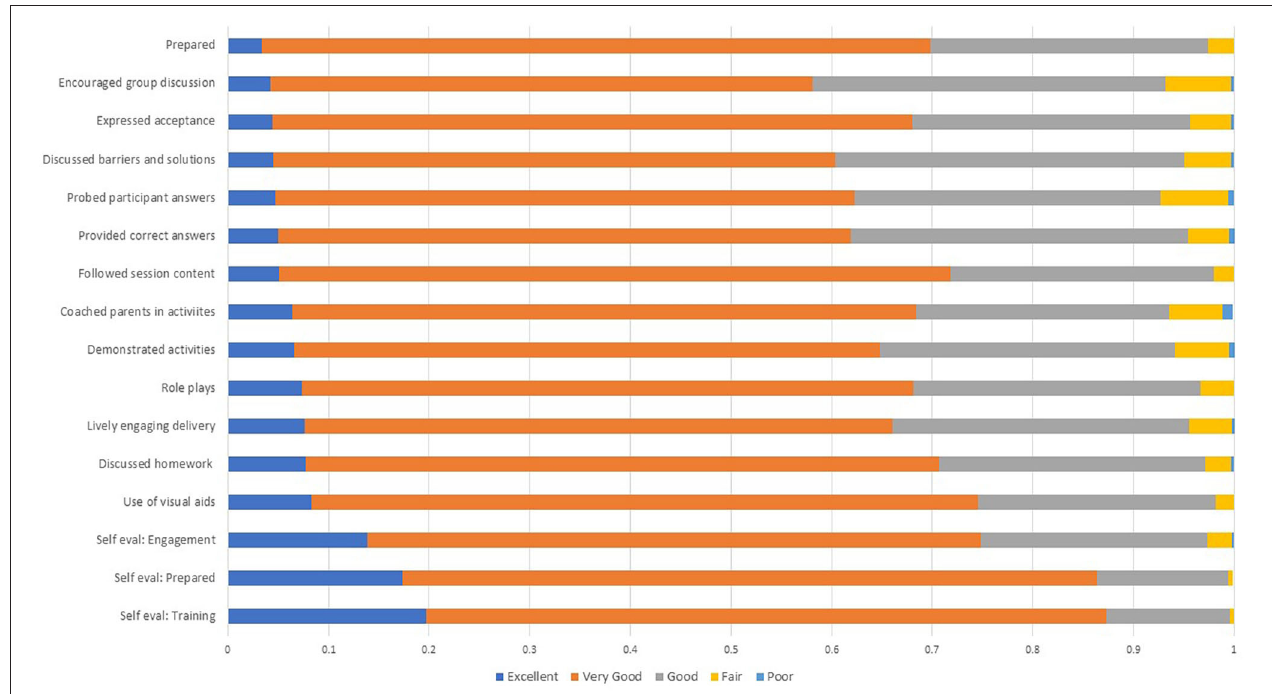
FIGURE 3 | Delivery Ratings: Supervisor and Self-Evaluations. Findings are mean ratings from supervisor or self-assessment monitoring forms across all 16 sessions and 40 intervention villages. N = 686 for supervisor monitoring forms; N = 2,043 for CHV self-assessment forms that include each home visit.